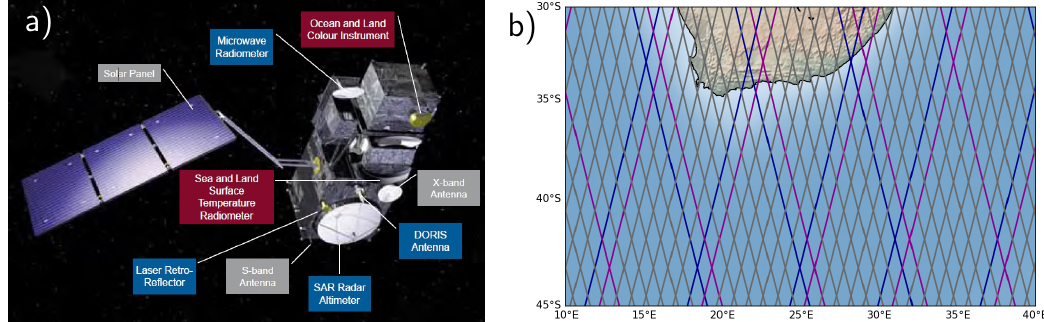
Figure 1. ( a ) Illustration of Sentinel-3 spacecraft showing most of the equipment payload (image courtesy of ESA). ( b ) Example of track pattern (all lines) surveyed by Sentinel-3A in 27 days in the Agulhas region, South Africa. Blue lines show the nearly uniform coarser coverage from a 4-day period (sub-cycle), with magenta lines showing the subsequent 4 days. [Left-hand figure taken from [2]]. Both S3A and S3B were placed in sun-synchronous orbits with a mean altitude above the Earth of 815 km, giving an orbital period of 101 min, such that after 385 complete revolutions (27 days), the ground-track of the satellite repeated to within less than a kilometre. The inclination of the orbits is 98.65 ◦ , permitting coverage between 81.3 ◦ S and 81.3 ◦ N, with data being collected over all surfaces (marine, cryosphere and land). S3A has always been in the same 27-day repeat cycle, with a pattern of ascending and descending tracks 0.94 ◦ apart in longitude (104 km at the Equator). The pattern of tracks is such that after 4 days there is quasi-global coverage with a wide ( ∼ 7 ◦ ) spacing of tracks, with successive 4-day periods occupying the set of tracks one step to the right (see Figure 1b). S3B